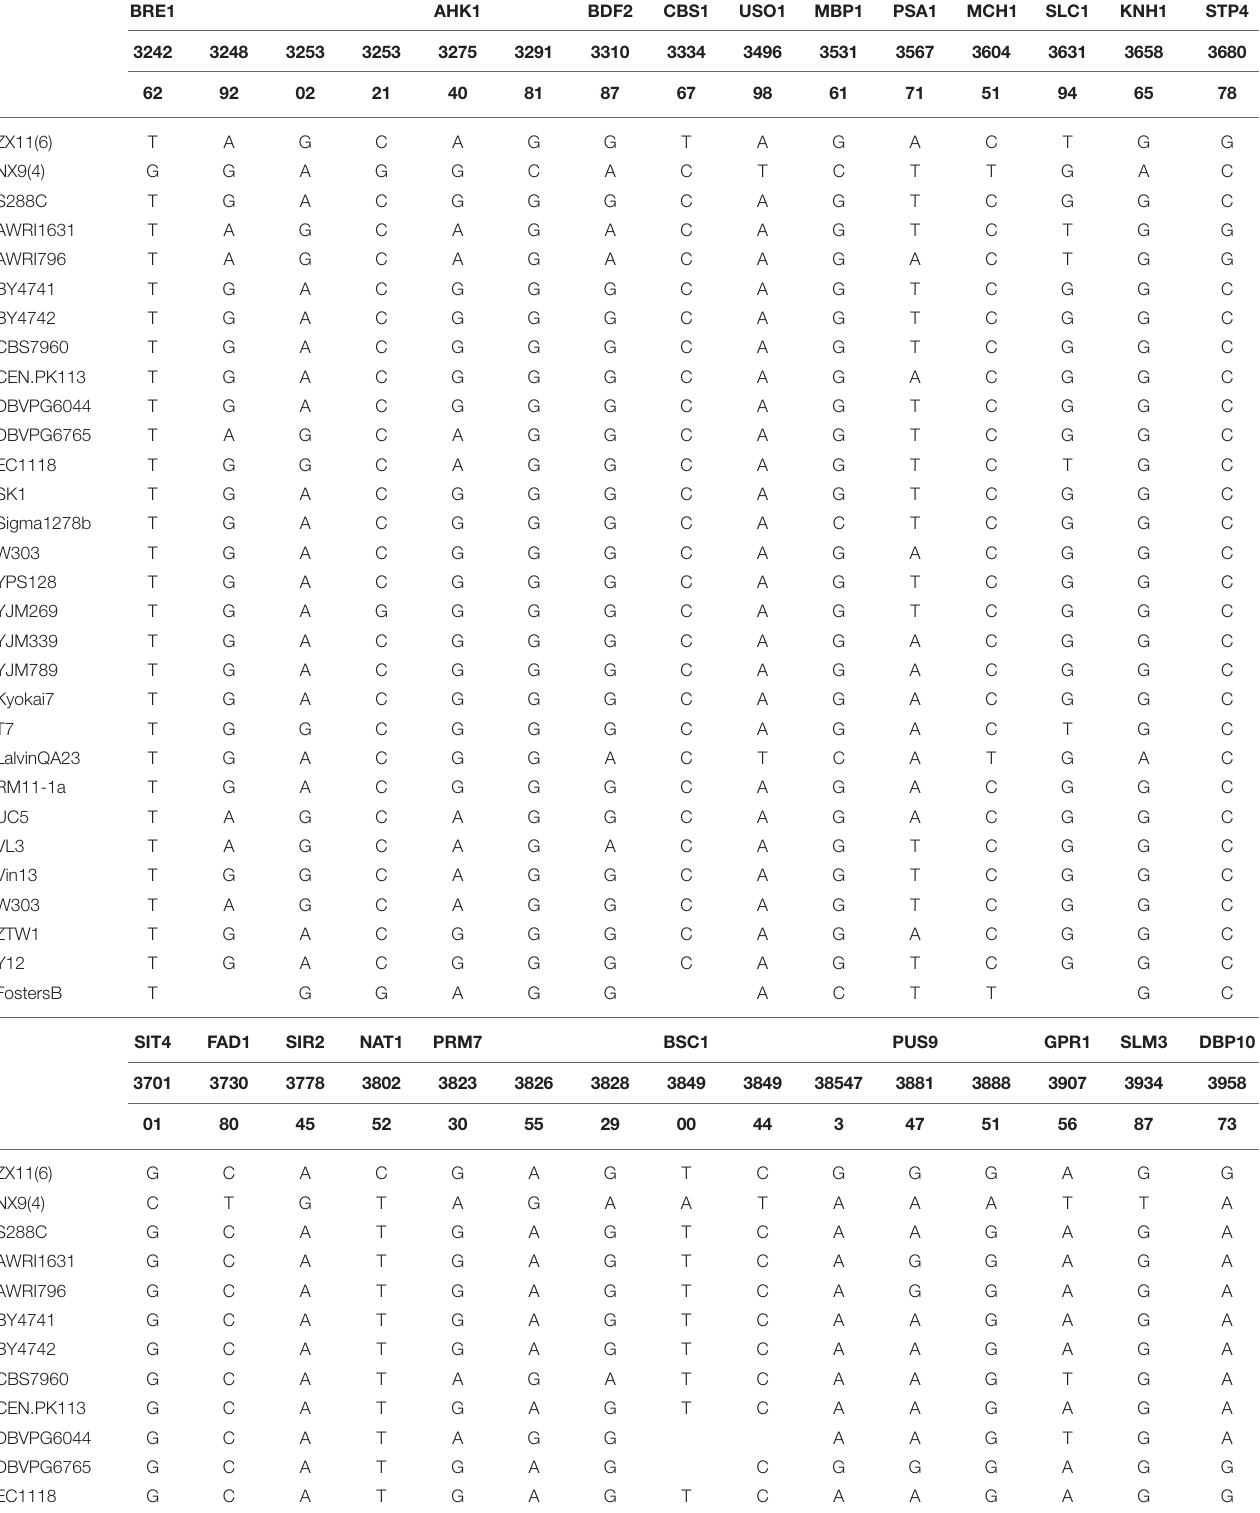
TABLE 2 | Occurrence of non-synonymous SNPs in 21 genes in other S. cerevisiae strains. BRE1 AHK1 BDF2 CBS1 USO1